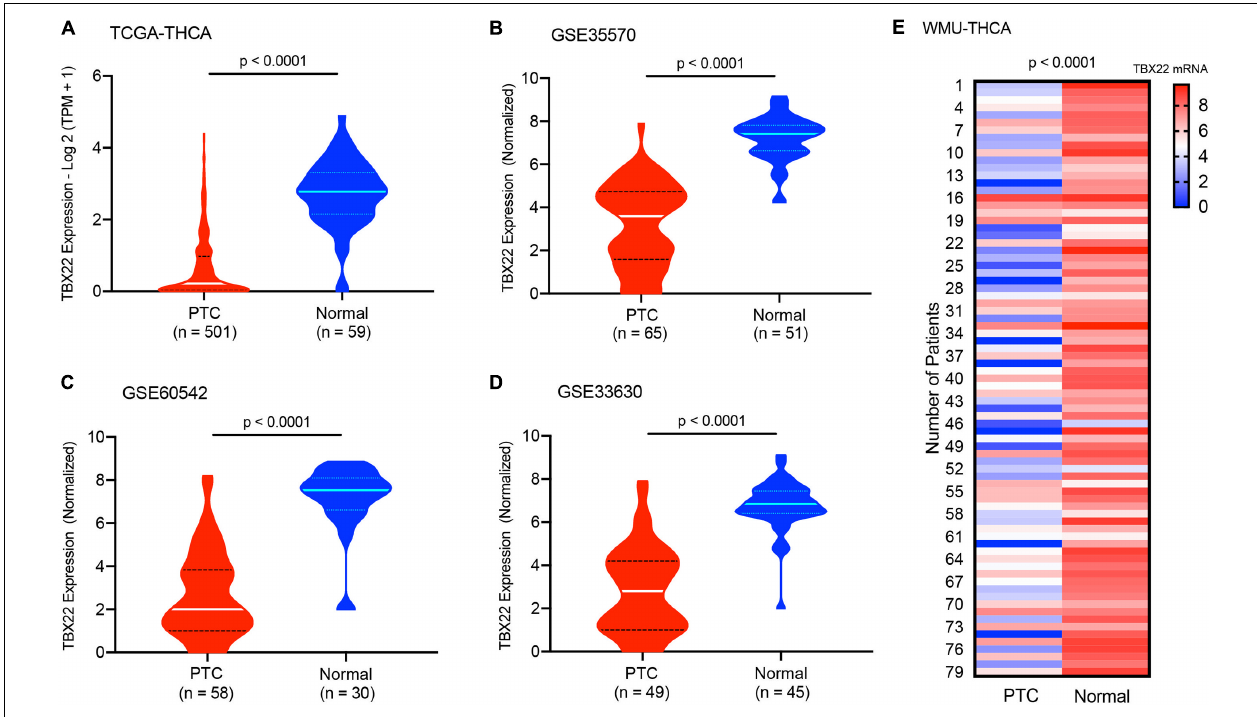
FIGURE 1 | T-box transcription factor 22 ( TBX22 ) levels in normal and malignant thyroid tissues. The TBX22 transcript levels in papillary thyroid cancer (PTC) and adjacent normal thyroid tissues from the (A) TCGA-THCA, (B) GSE35570, (C) GSE60542, and (D) GSE33630 datasets are presented as violin plots. (E) TBX22 expression in local THCA tissues compared with the paired normal thyroid samples by qRT-PCR. Statistical methods were as follows: (A–D) Wilcoxon rank-sum test; (E) Wilcoxon signed-rank